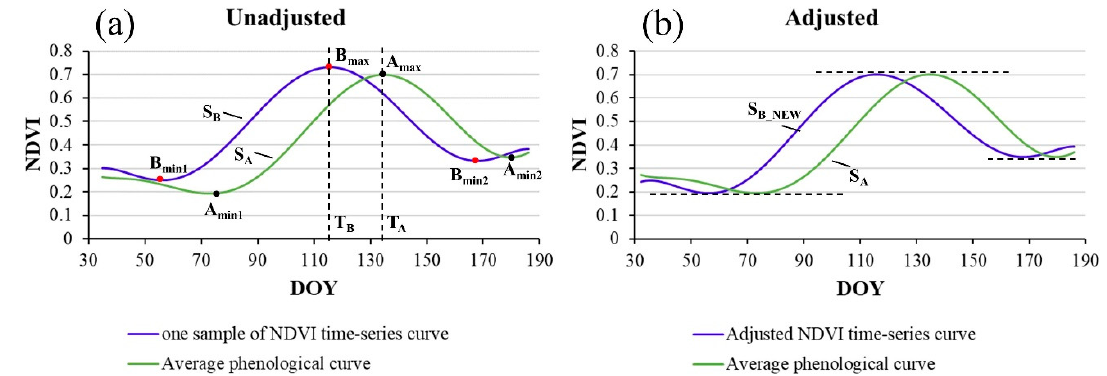
Figure A1. A comparison of the NDVI time-series curve and the average phenological curve before ( a ) and after ( b ) wave- form adjustment.